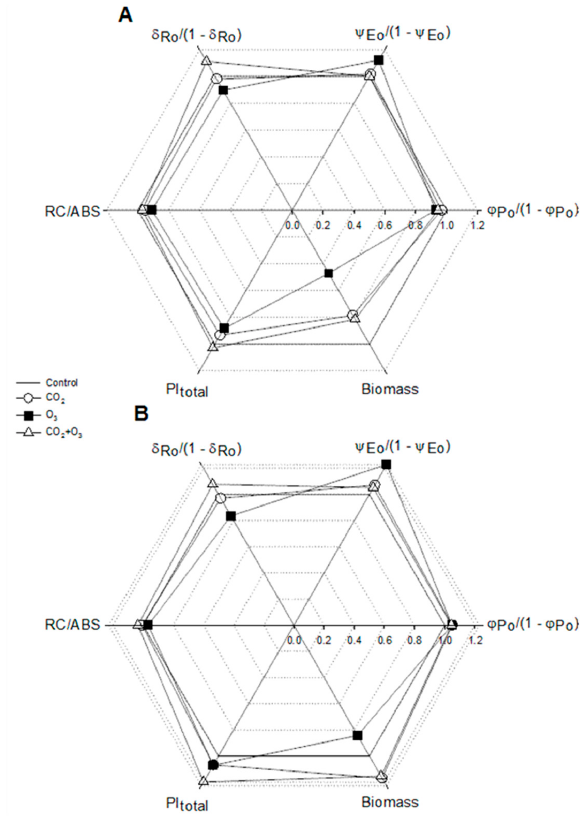
Figure 5. Radar plot of selected biophysical parameters (PI total , RC/ABS, φ Po /(1 − φ Po ), ψ Eo /(1 − ψ Eo ), δ Ro /(1 − δ Ro )) and biomass for canola. Values were normalized on those of the control, which is presented by the regular hexagon for well-watered ( A ) and water-stressed ( B ) plants.